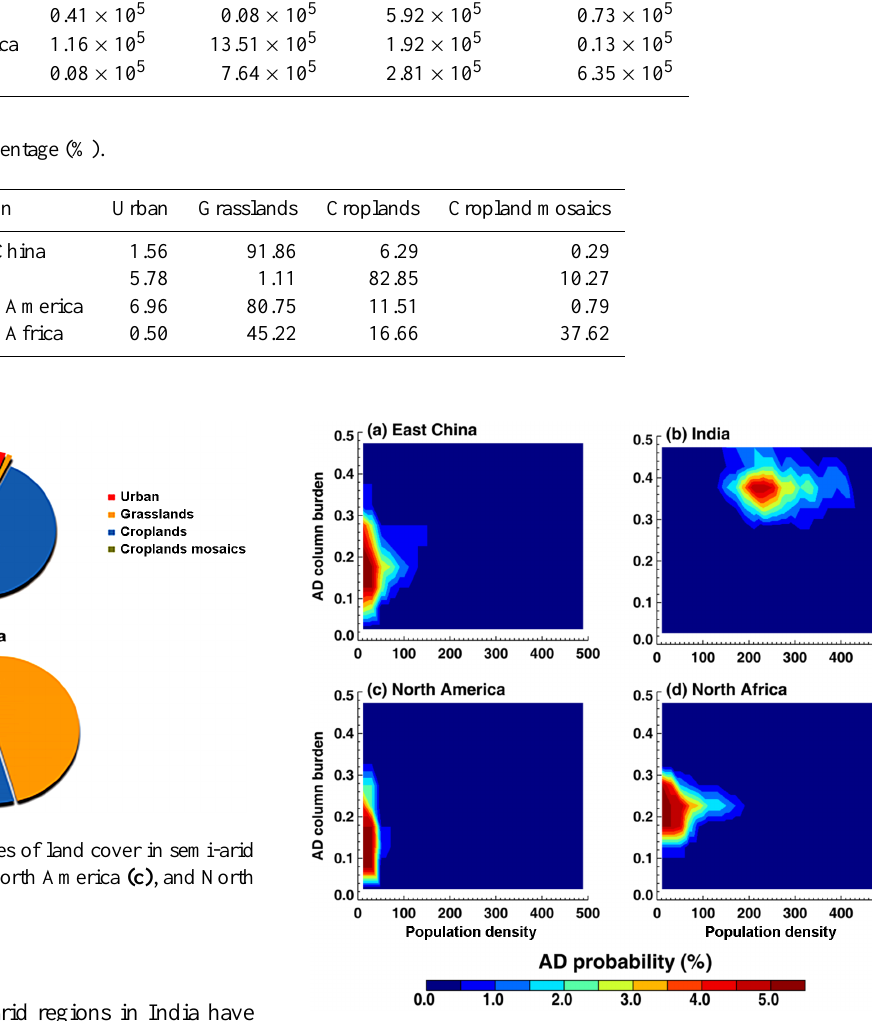
Figure 13. Anthropogenic dust (AD) probability distribution in dif- ferent population density (personskm − 2 ) and AD column burden (gm − 2 ) value in semi-arid regions of East China (a) , India (b) , North America (c) , and North Africa (d)